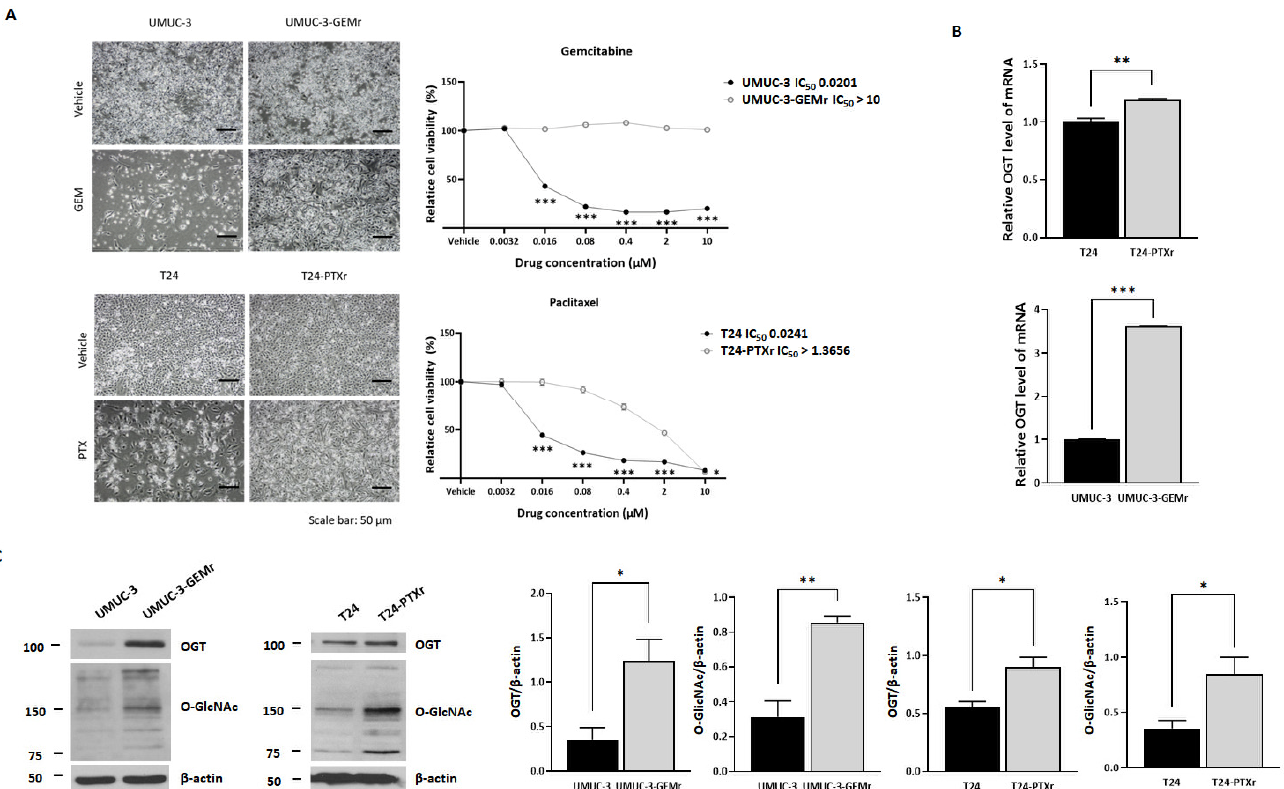
Figure 2. OGT expression and activity was upregulated in UCB cell models with acquired chemoresistance to gemcitabine (GEM) and paclitaxel (PTX). ( A ) Cell morphology of resistant and nonresistant cells observed under a light microscope (magnification, ×10). UMUC ‐ 3 and UMUC ‐ 3 ‐ GEM ‐ resistant (GEMr) cells were treated with a vehicle or 10 μ M GEM. T24 and T24 ‐ PTX ‐ resistant (PTXr) cells were treated with a vehicle or 1 μ M PTX. Observations were made 72 h after treatment. After observation, cell viability was analyzed by MTT assay. The data represent at least three independent experiments and error bars indicate the mean ± SEM. ( B ) qRT ‐ PCR was used to detect OGT and GAPDH expression in UMUC ‐ 3/UMUC ‐ 3 ‐ GEMr and T24/T24 ‐ PTXr cells. Error bars indicate the mean ± SEM for three independent regions each. ( C ) Immunoblots of lysates derived from UMUC ‐ 3, UMUC ‐ 3 ‐ GEMr, T24, and T24 ‐ PTXr cells against OGT and O ‐ GlcNAc. β‐ actin was used as the loading control. Error bars indicate the mean ± SEM for three independent regions each. For all panels * p < 0.05; ** p < 0.01; *** p < 0.001.